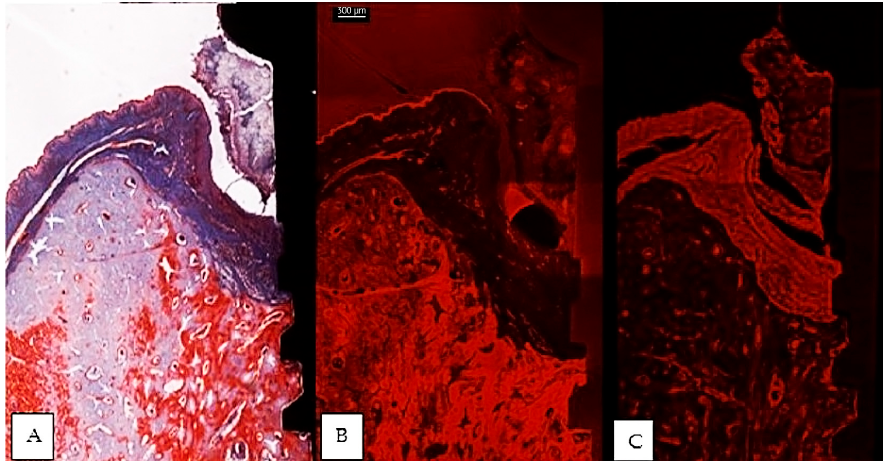
Figure 3. Comparative images of the same implant, between a thin section in light microscopy, Masson Goldner Anilin blue stain ( A ), same thin section in CLSM ( B ) and a thick section in CLSM ( C ). Morphological preservation of tissular integrity is better seen in the thick section. (implant #5, buccal aspect, bar measure for all three images is 300 µm).